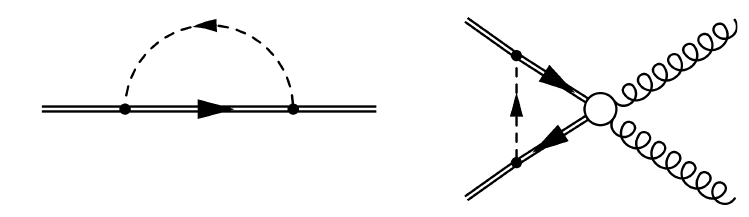
Figure 1 . Example diagrams for Higgs-exchange contributions to the one-loop anomalous